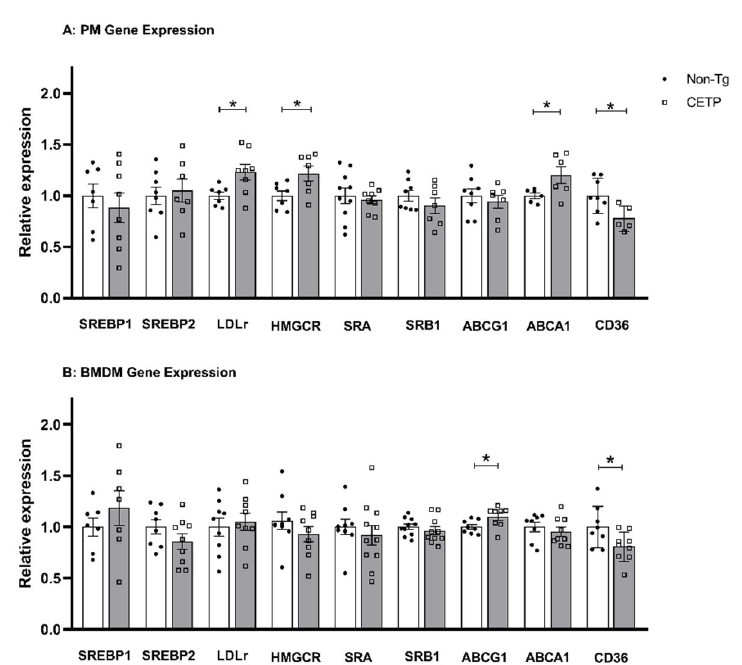
Figure 6. CETP expression in macrophages changes the expression of cholesterol homeostasis related genes. Relative gene expression levels were measured in thioglycolate-elicited peritoneal macrophages (PM) ( A ) and in bone marrow derived macrophages (BMDM) ( B ) from human CETP-Tg and non-transgenic mice (Non-Tg). * p < 0.05. Sterol response element binding protein 1 and 2 (SREBP1, SREBP2), LDL receptor (LDLr), 3-hydroxy-3-methyl-glutaryl-CoA reductase (HMGCR), scavenger receptor class A (SRA), scavenger receptor class B member 1 (SRB1), ATP-binding cassette transporter A1 and G1 (ABCA1, ABCG1), cluster determinant 36/fatty acid translocase